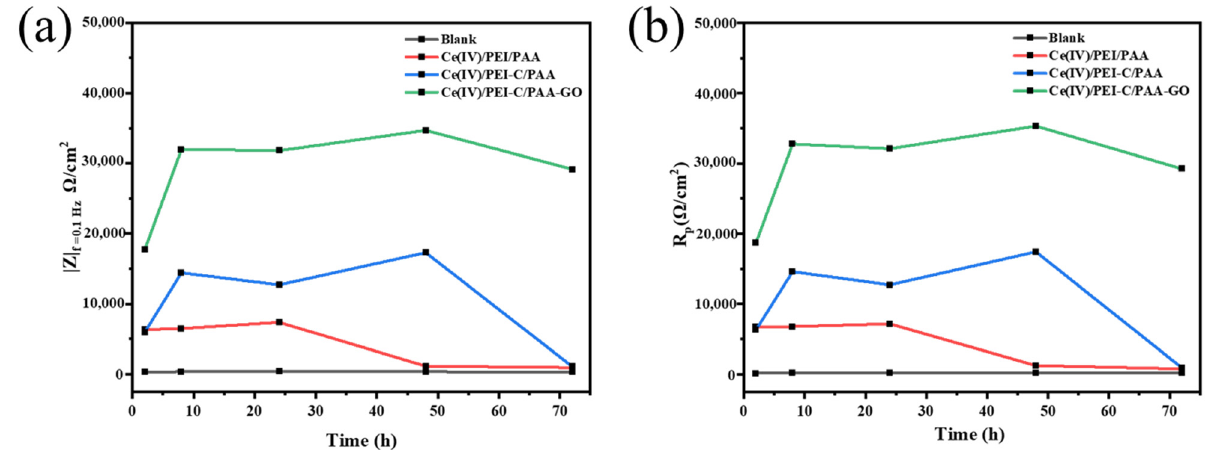
Figure 7. The variation of: ( a ) the impedance modulus (f = 0.1 Hz) and ( b ) polarization resistance with the immersion times for coated and bare AZ31B alloys of different compositions in a 3.5 wt% NaCl solution. Table 1. Electrical parameters for different coating systems immersed in a 3.5% NaCl solution; the values were obtained by fitting the EIS data.